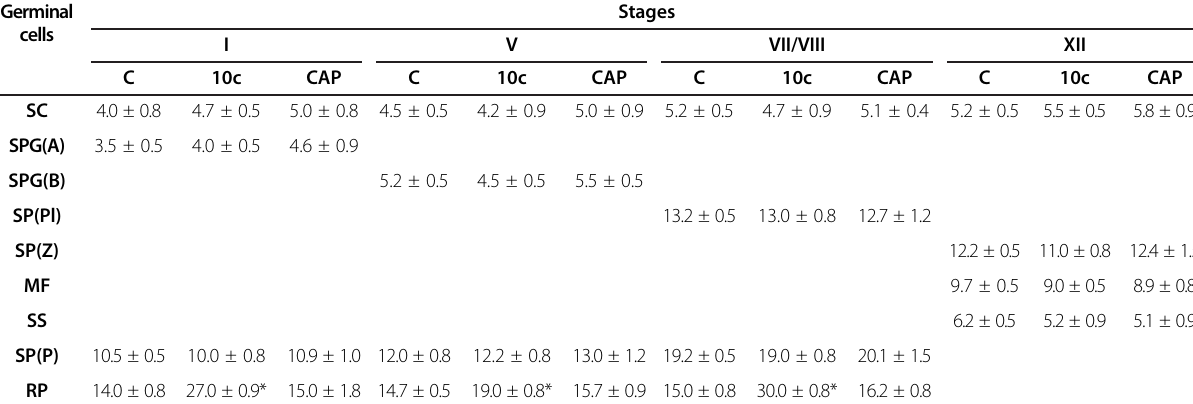
Table 1 Quantitative analysis of germinal cells in male adult mouse seminiferous epithelium treated with vehicle (C), captopril (CAP) or BPP-10c (10c) Germinal